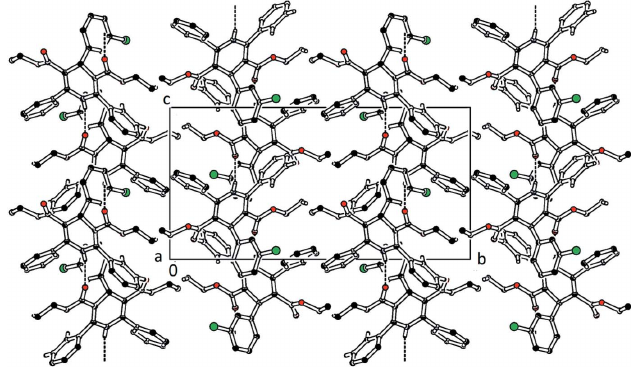
Figure 2 The packing viewed down [100]. Hydrogen bonds are shown as dashed lines.